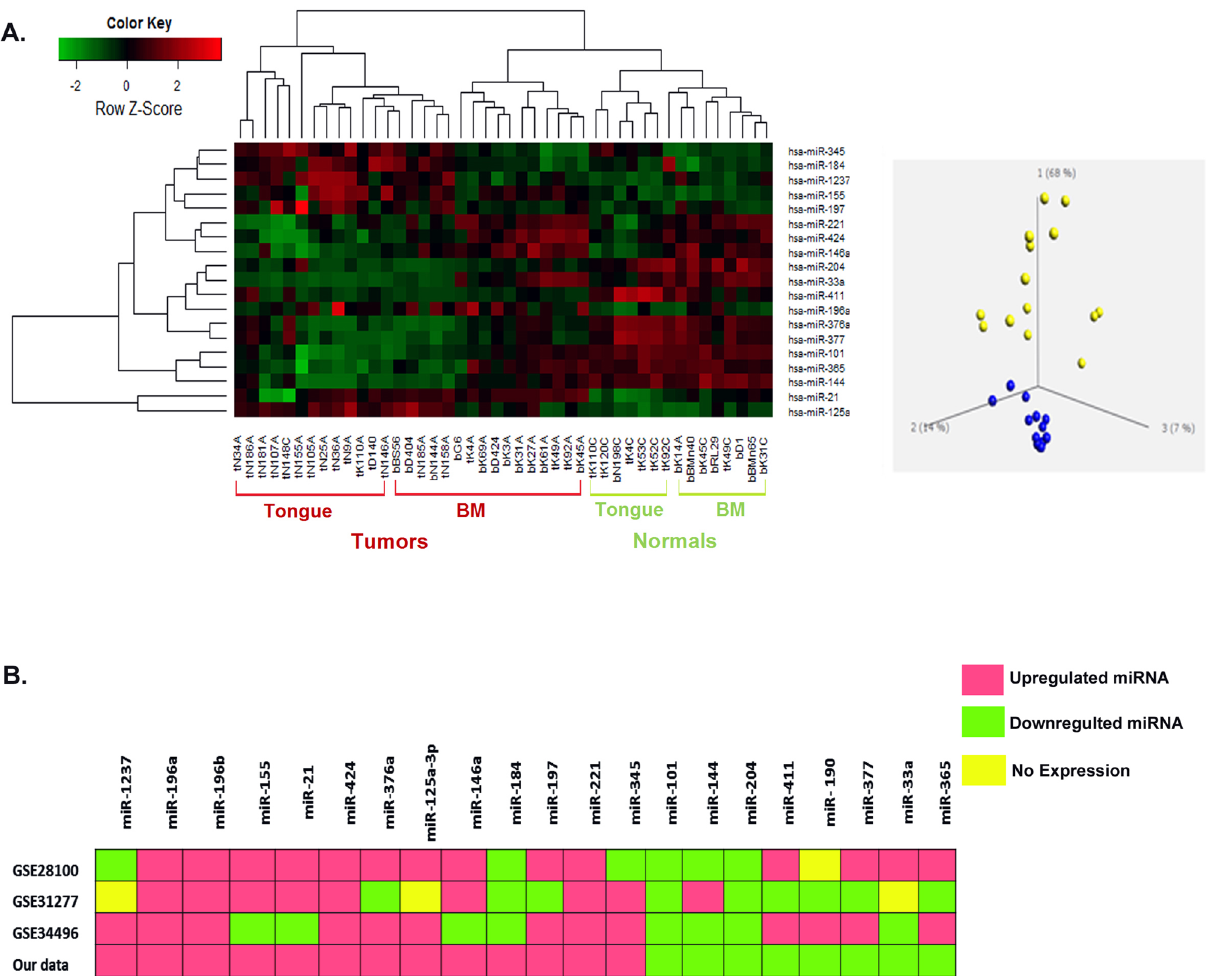
Figure 1. ( A ) Supervised hierarchical clustering using signature miRNAs differentiating samples site-wise into distinct Tongue and Buccal mucosa clusters with cut off Fold Change > 1.5 and p value < 0.01. In the heatmap, samples are labelled with prefix ‘t’ for Tongue and ‘b’ for Buccal Mucosa (BM) and the suffix ‘C’ denotes Normals while the rest represents Tumor samples. ( B ) Heatmap showing the expression status of signature miRNAs in three external datasets compared to our profile; GSE28100 (USA, tongue), GSE31277 (Brazil, OSCC) and GSE4496 (USA, OSCC). Pink boxes represent upregulated miRNA, green boxes represent downregulated miRNA and yellow boxes indicates absence of miRNA